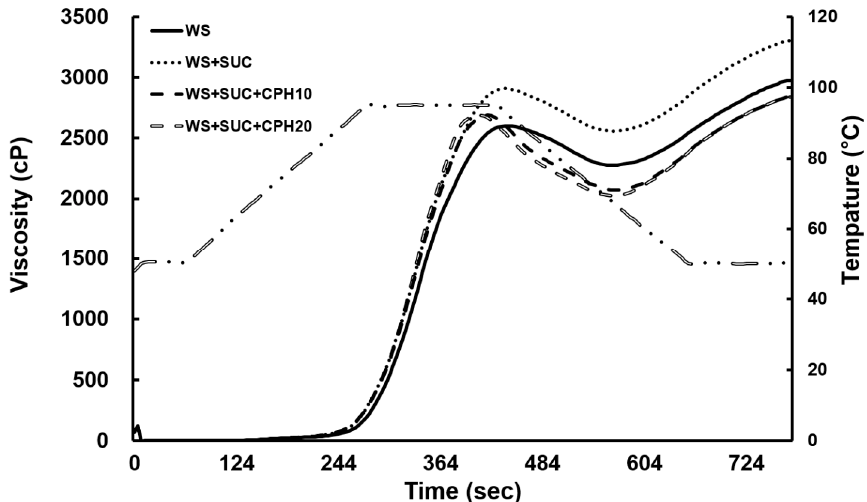
Table 2. Pasting properties of wheat starch with added sucrose and citrus peel hydrolysates. Peak Viscosity